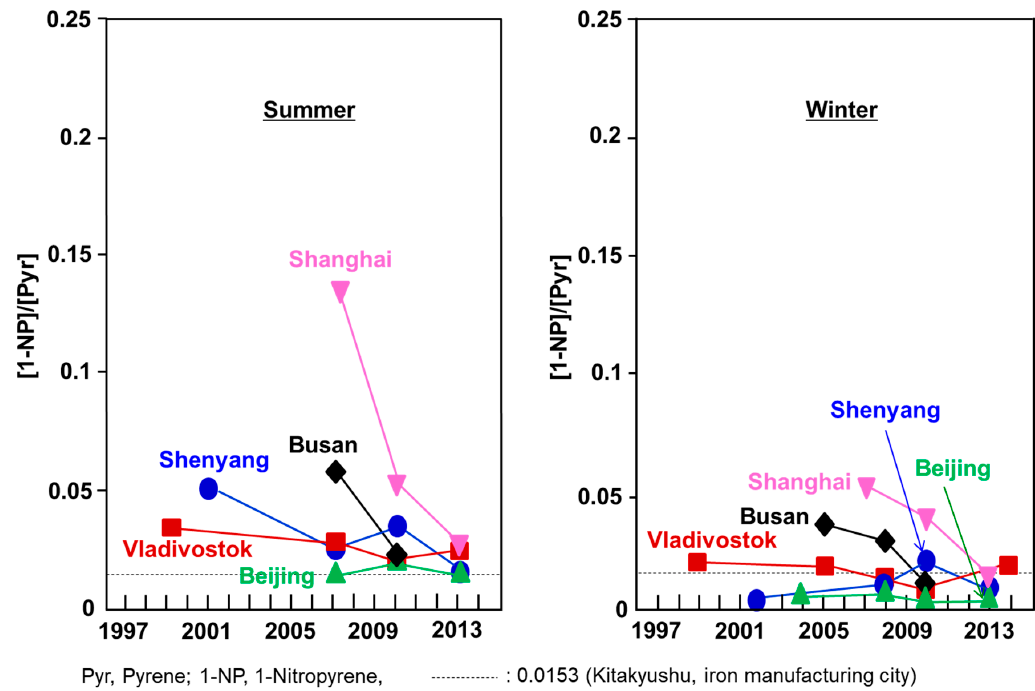
Figure 6. Diagnostic [1-NP]/[Pyr] ratios.